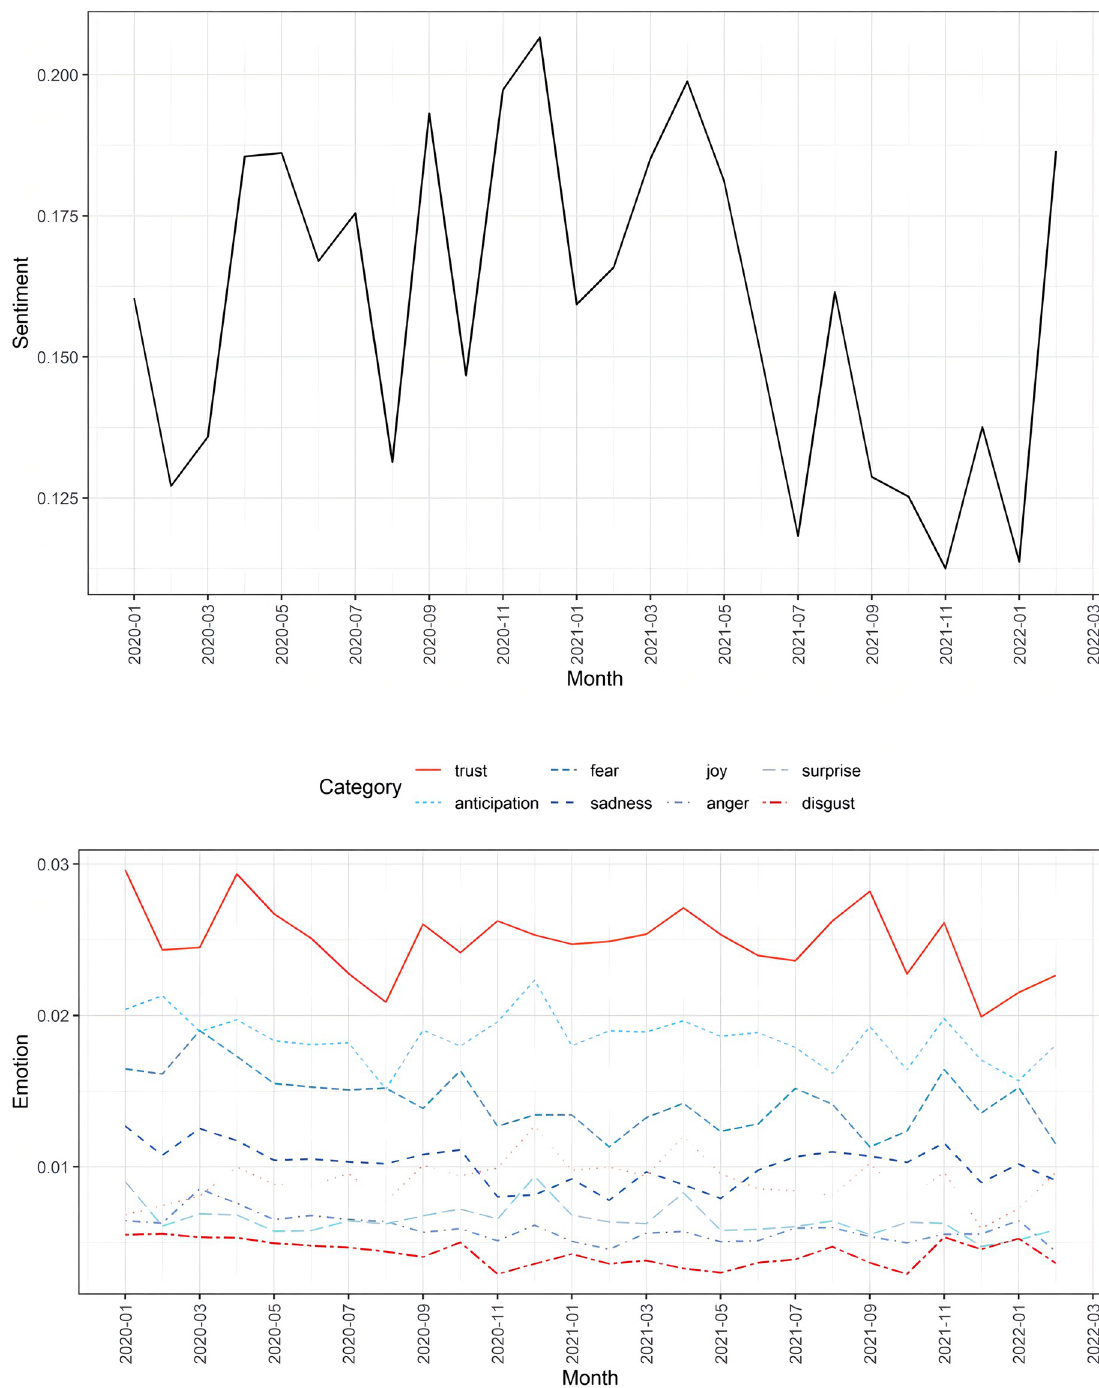
Fig 2. Sentiment and emotion trajectory of WHO COVID-19 press conferences.